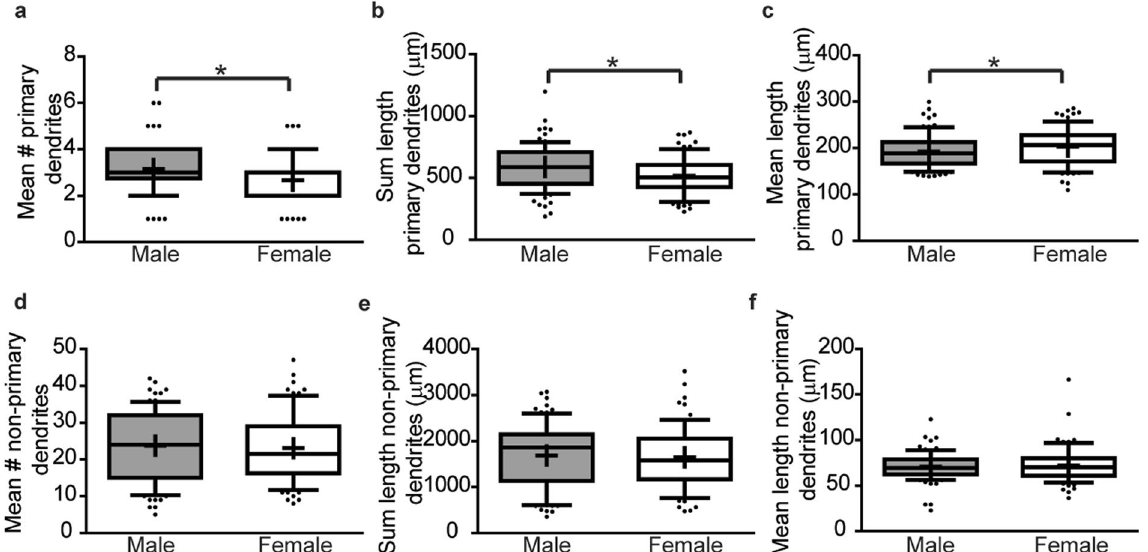
Figure 5. In cortical cultures, primary dendrite number is greater but average length less in male vs. female neurons. Sex-specific neuron-glia co-cultures were established from P0 mouse neocortices, transfected with MAP2B-GFP plasmid on day in vitro (DIV) 6 and fixed on DIV 9. Dendritic morphology was assessed by quantifying: ( a ) the number of primary dendrites; ( b ) the summed length of primary dendrites; ( c ) the mean length of primary dendrites, ( d ) the number of non-primary dendrites; ( e ) the summed length of non-primary dendrites; and ( f ) the mean length of non-primary dendrites. In box plots, “ + ” indicates the mean; whiskers, the 10–90 th percentile (n = 76–82 neurons per sex from at least five independent dissections). Significant differences were determined using Student’s T-test for parametric data ( b ), and Mann-Whitney U test for nonparametric data ( a , c , d , e , f ). Asterisk indicates a significant difference between groups at p ≤